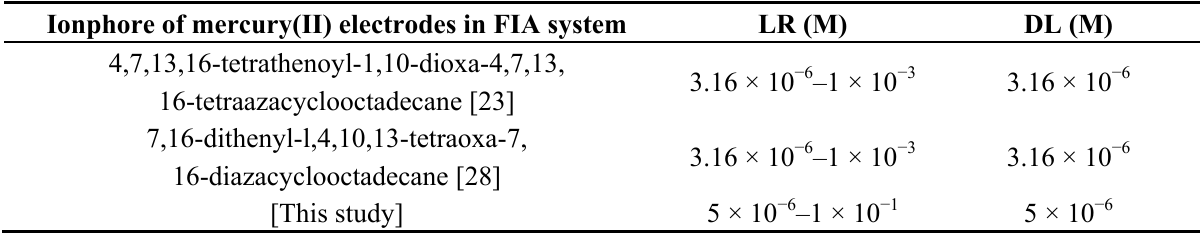
Table 4. The performances of mercury(II) ISEs in FIA